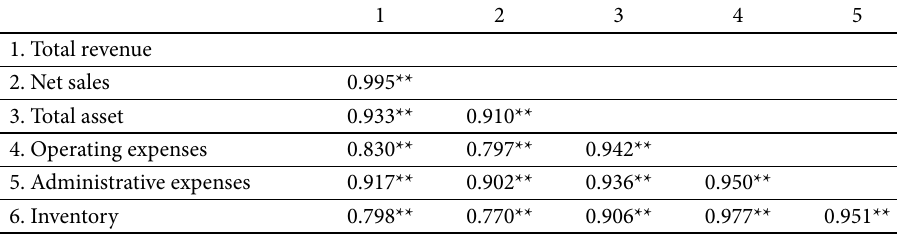
Table 3. Spearman’s correlation coefficients between input and output